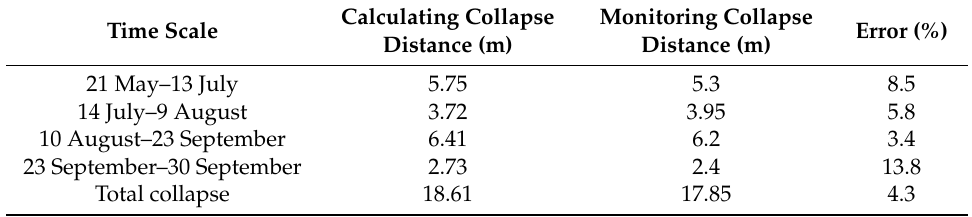
Table 8. Numerical results, field measurements and errors for surveying Section 4 of Figure 1.